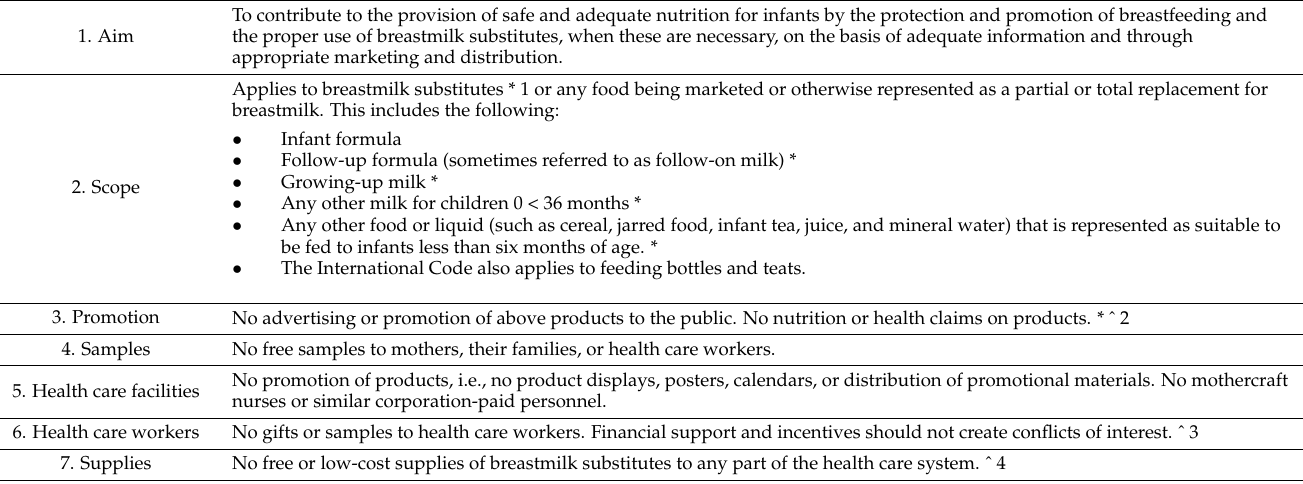
Table A1. Summary of the International Code of Marketing Breast-Milk Substitutes, adapted from the IBFAN-ICDC Code Monitoring Kit